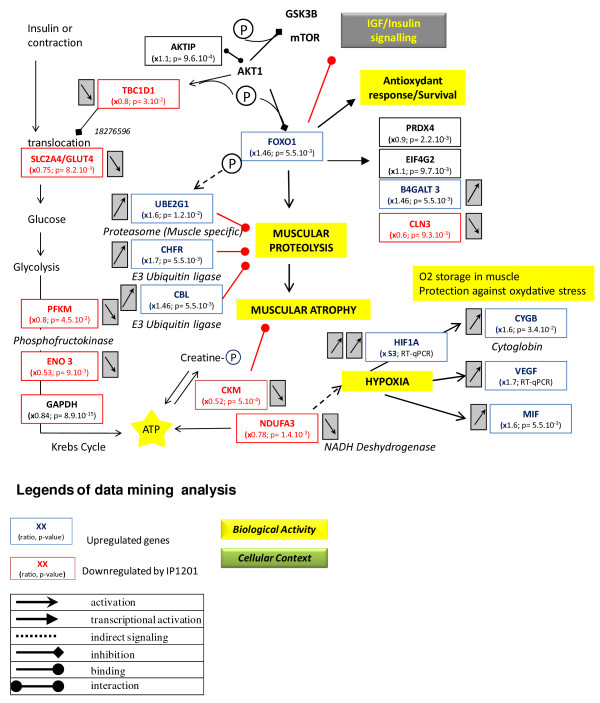
Main pathway disorders leading to muscle proteolysis, atrophy, hypoxia and anti-oxidant response. Legends of the figures 
2-
5 are indicated under this figure.